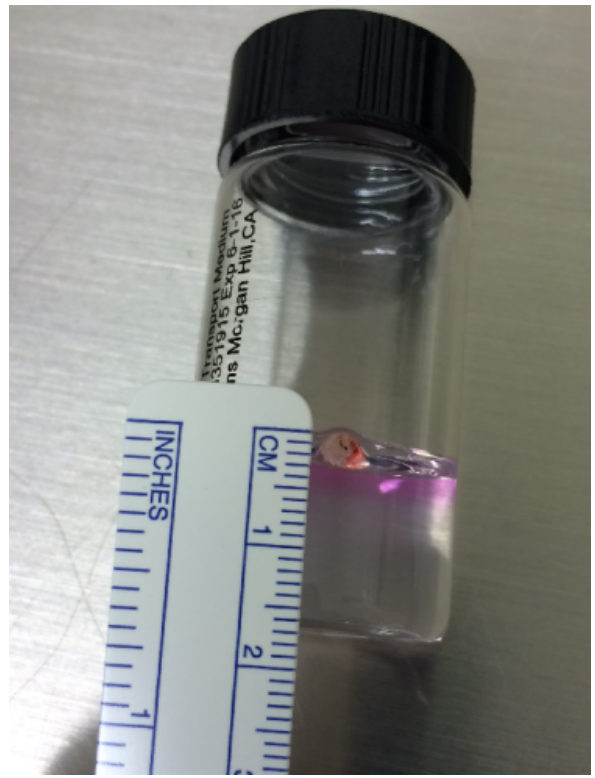
Figure 3: The removed foreign